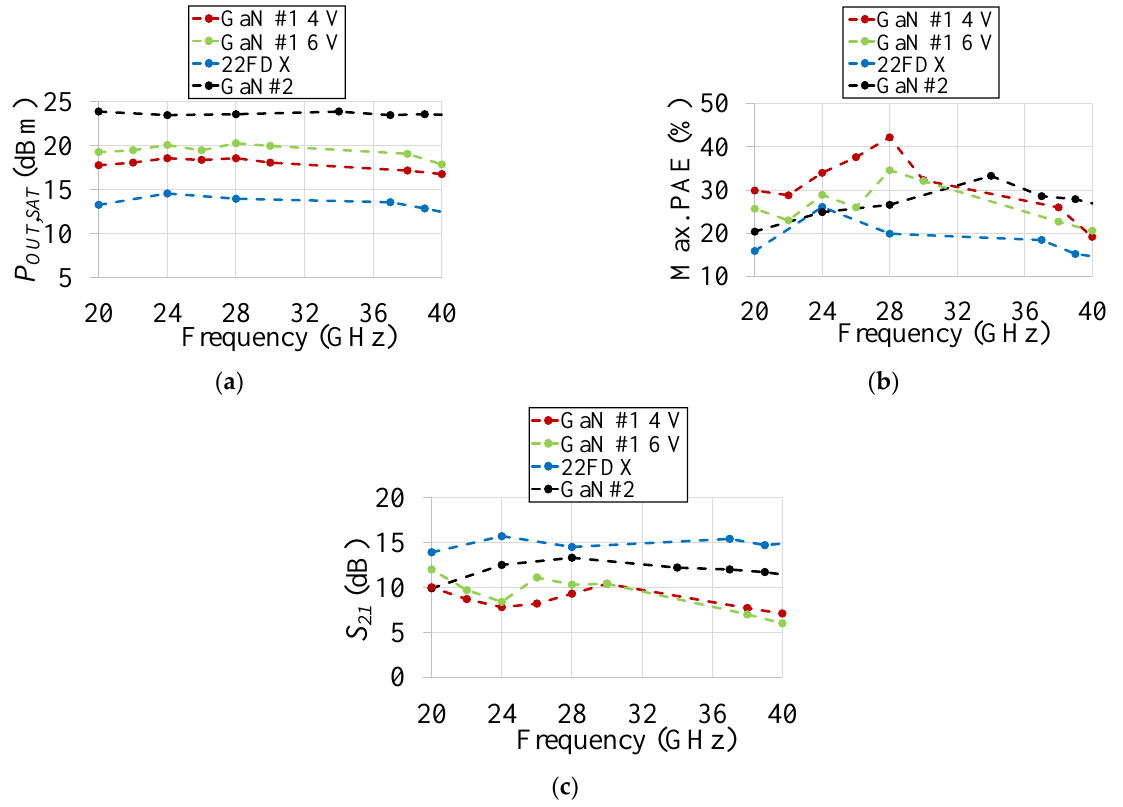
Figure 17. Measurements of the broadband single-ended GaN and the broadband CMOS FD-SOI PAs and EM PEX simulations of the broadband differential GaN for ( a ) P OUT,SAT , ( b ) maximum PAE, and ( c ) S 21 vs. frequency.